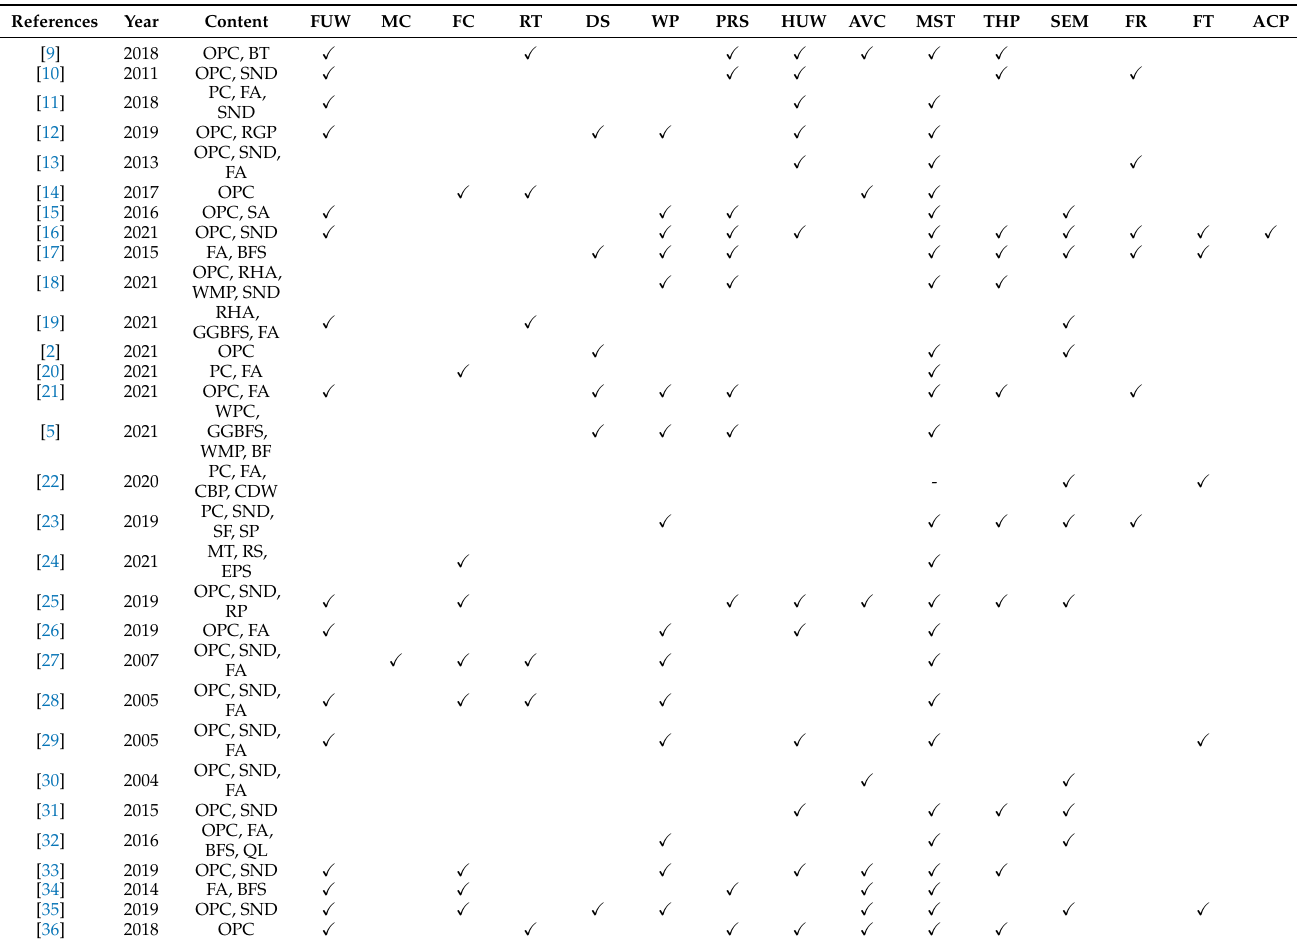
Table 1. Some properties of foam concretes